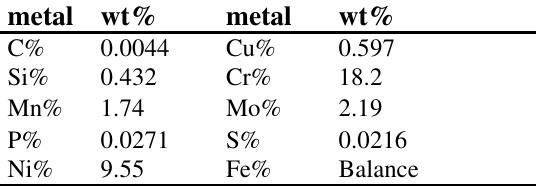
Thermal properties of stainless steel 316L and tool [13]. Property Values Unit Thermal Conductivity of workpiece ( w ՝ ) Specific Electrical Resistivity Specific heat at 20 x ° Thermal diffusivity Specific force Thermal Conductivity